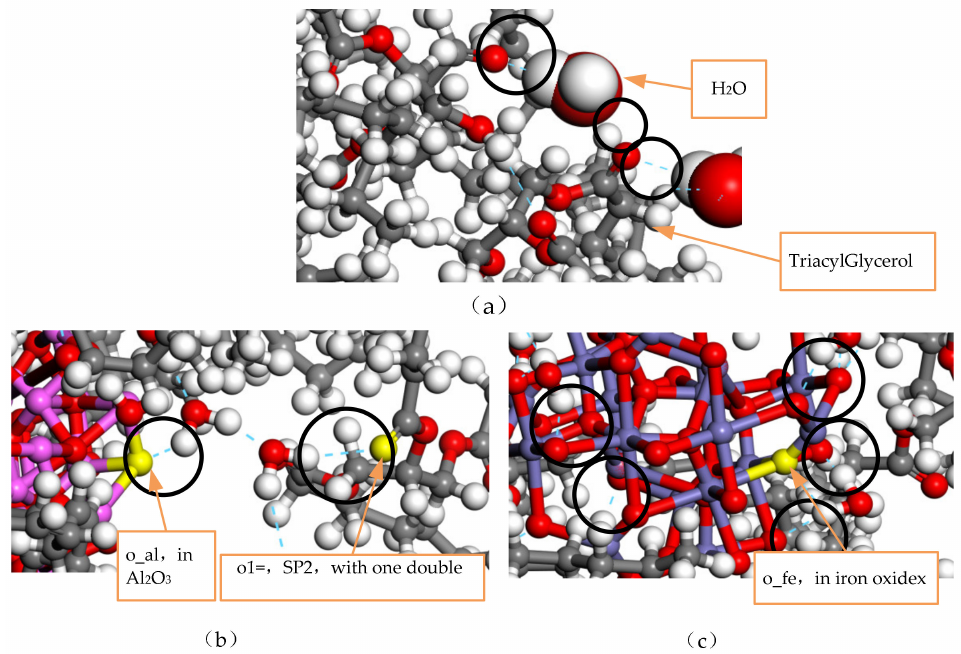
Figure 9. Type of hydrogen bonding in the model before and after the modification: ( a ) Model without added nanoparticles, ( b ) Al 2 O 3 nano-modified model, ( c ) Fe 3 O 4 nano-modified